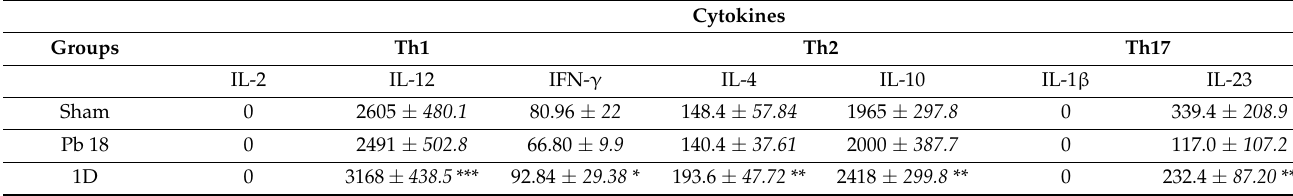
Table 2. Th1, Th2 and Th17 cytokine production 51 days post